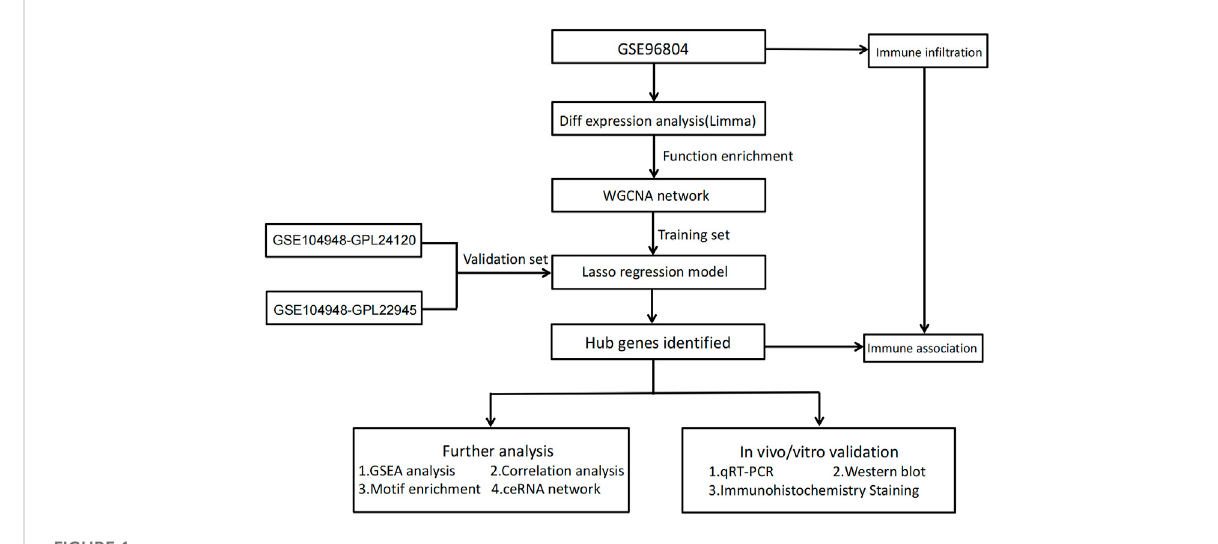
FIGURE 1 Study work fl ow.